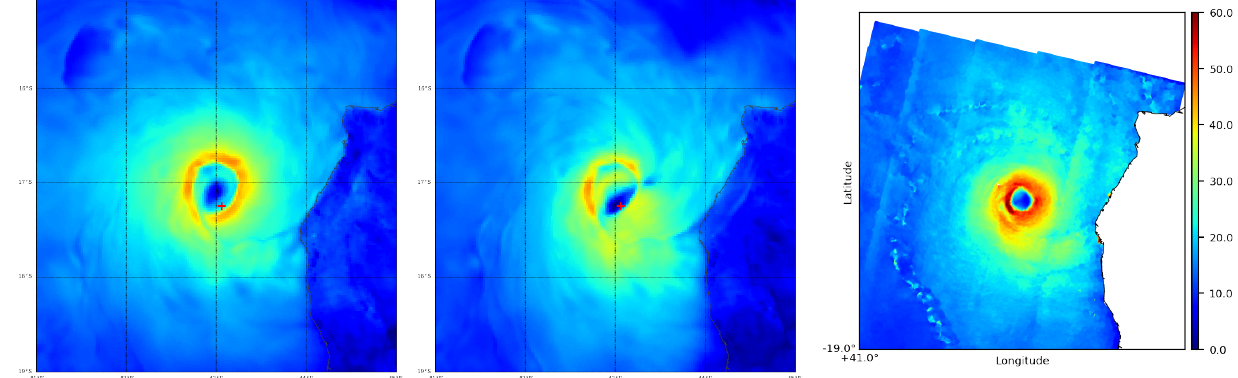
Figure 21. Background ( left ) and analysis ( middle ) of 11 March 2019 03:00Z for SAR_12km_2ms and SAR wind speed observations ( right ) at 02:46Z in area (41° E–45° E, 15° S–19° S). Units are m · s − 1 . Red cross is the estimated TC center position interpolated from TC position extracted from BT on 11 March 2019 00:00Z and